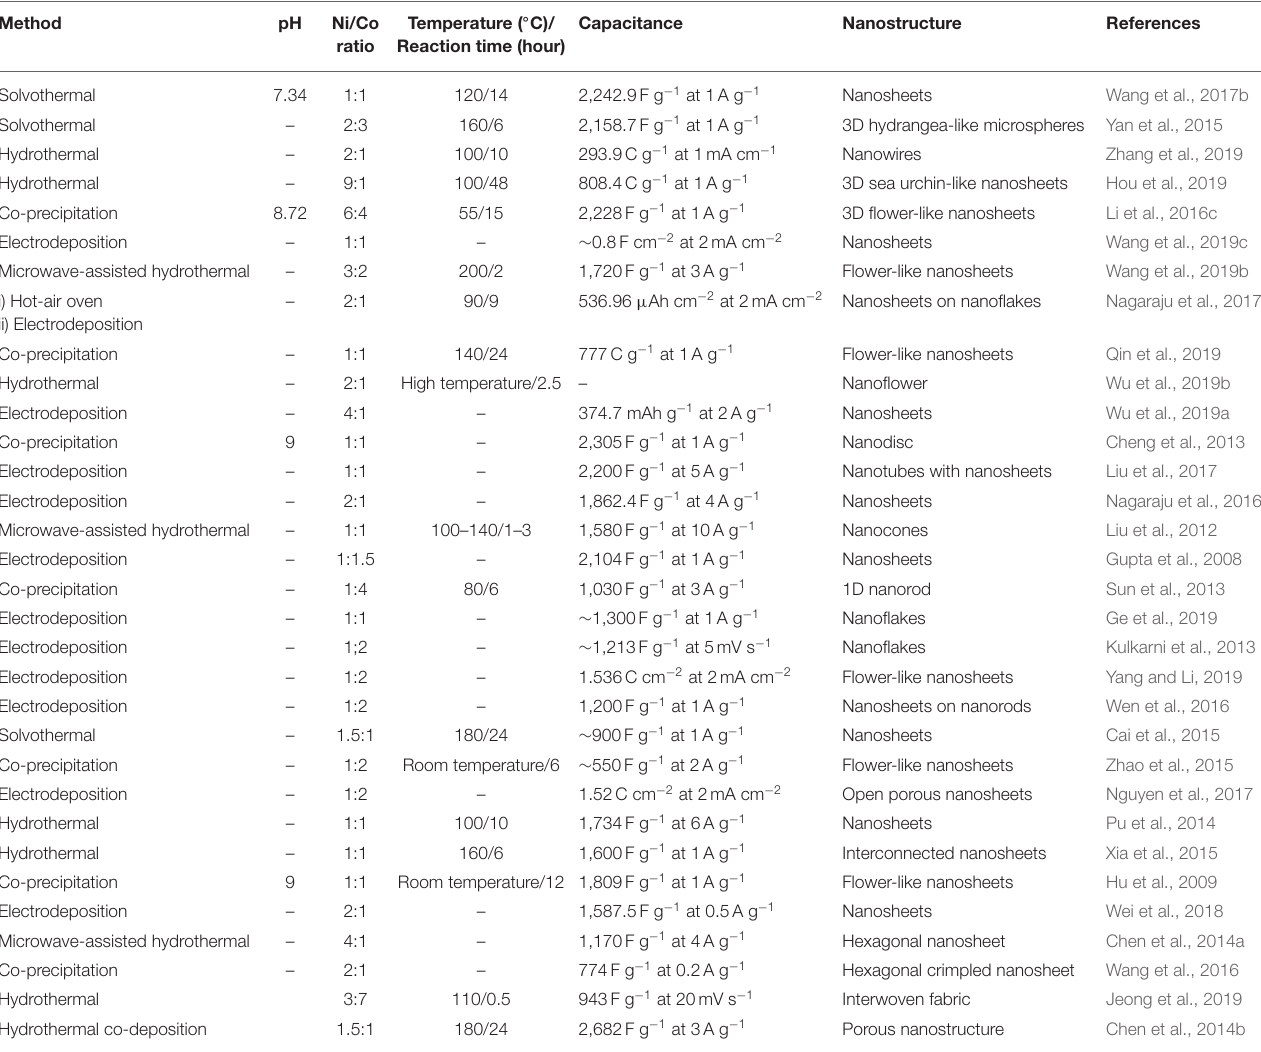
TABLE 2 | Summary of preparation condition, morphology, and specific capacitance of Ni-Co LDHs as supercapacitor